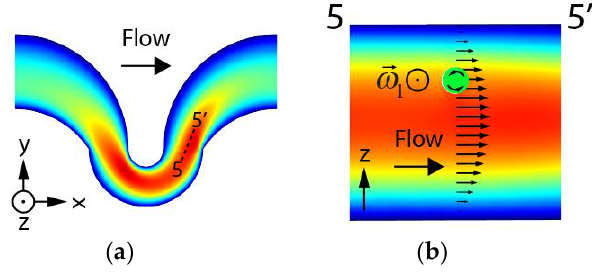
Figure 15. ( a ) Velocity magnitude at the half height of the channel; ( b ) Vertical section of the fluidic channel at the outlet region of the small curve showing the velocity magnitude distribution. The shear in the vertical direction induces an angular velocity vector contained in the x-y plane.